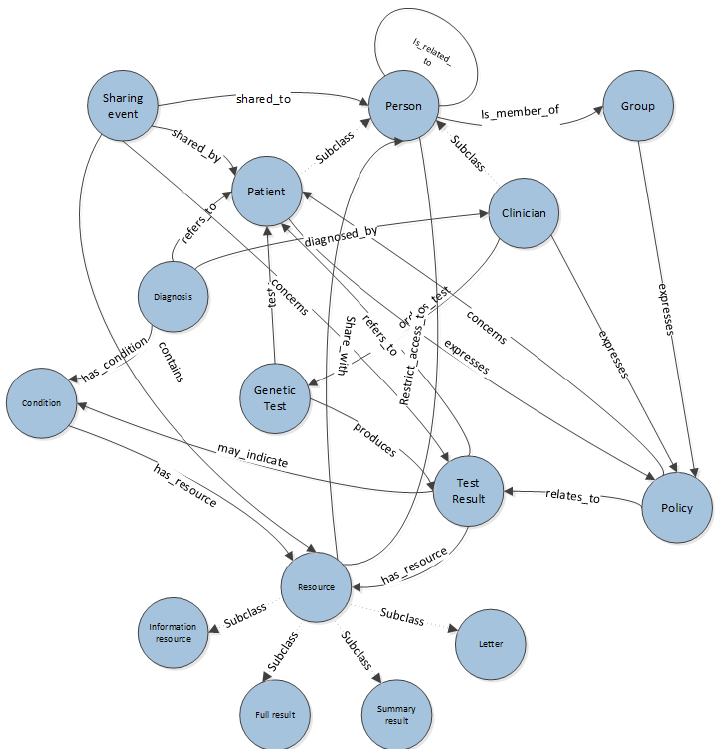
Figure 2. The myKinMatters conceptual